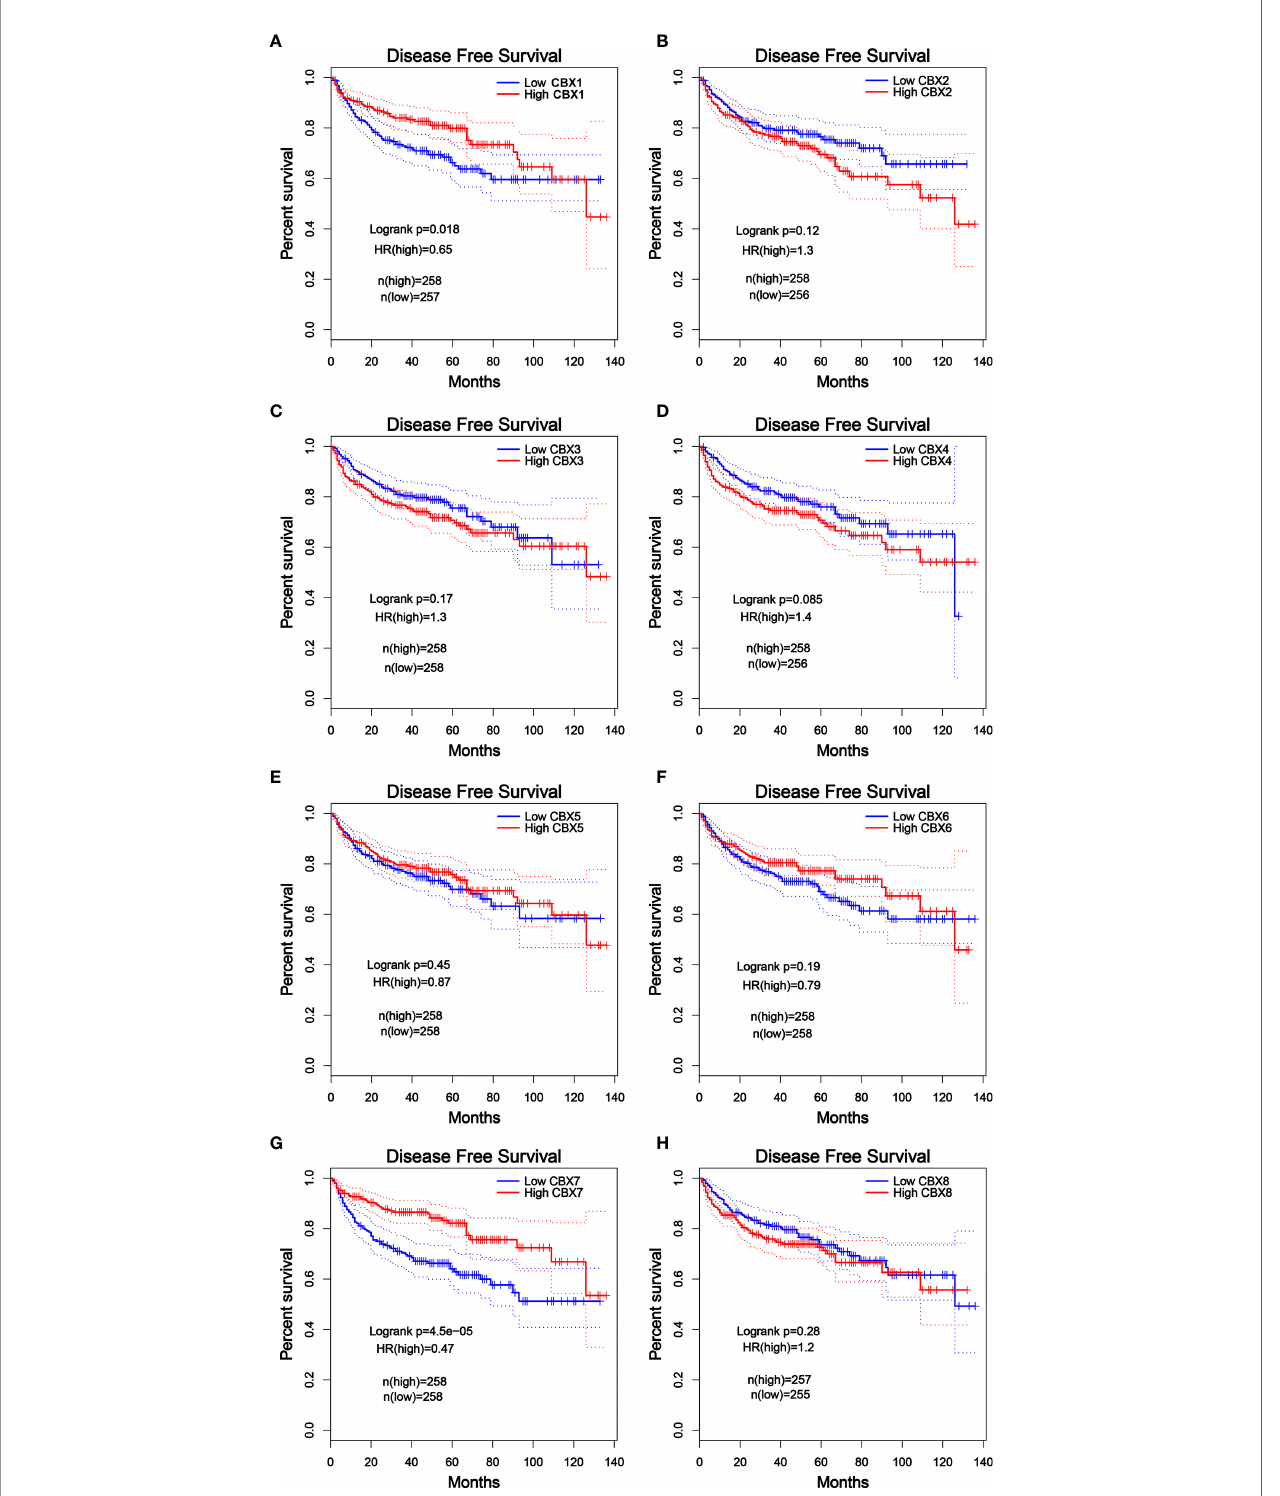
FIGURE 11 | The prognostic value of different expressed CBXs in ccRCC patients in the DFS curve (GEPIA). Low expression levels of CBX1 and CBX7 were signi fi cantly correlated with poor disease-free survival in ccRCC patients (A, G) . CBX2, CBX3, CBX4, CBX5, CBX6 and CBX8 expression showed no correlation with disease free survival in ccRCC patients (B – F, H)